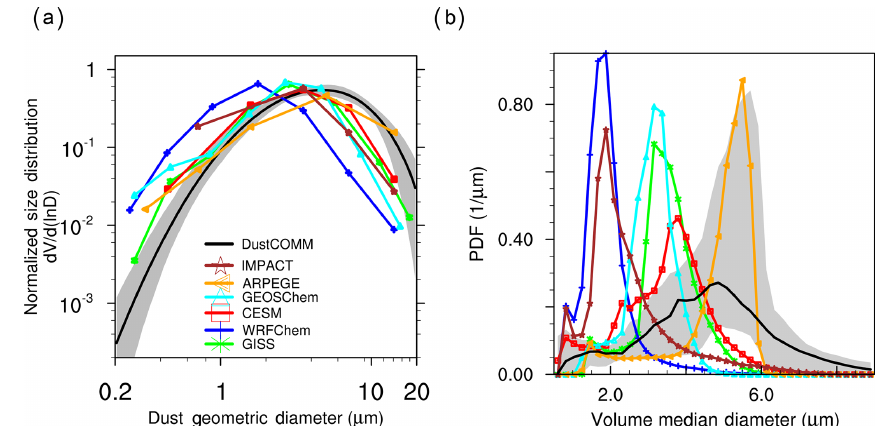
Figure 5. (a) Comparison between DustCOMM (black line) and model simulations (coloured lines) of the globally averaged dust particle size distribution (PSD). The grey shading denotes the 95% confidence interval for the DustCOMM product. (b) The probability distribution of the volume median diameter (µm) of the PSD for DustCOMM (black line) and the individual model simulations (coloured lines) over all locations and height levels.